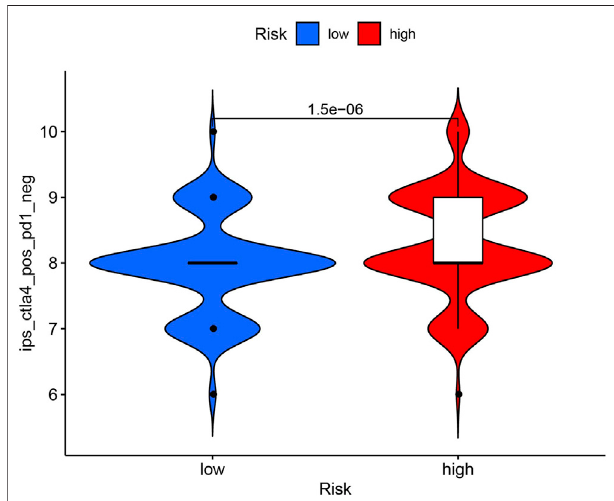
FIGURE 10 | Low-risk group was more likely to respond to anti-CTLA4 immunotherapy. ICPs: immune checkpoints; ICBs: immune checkpoint